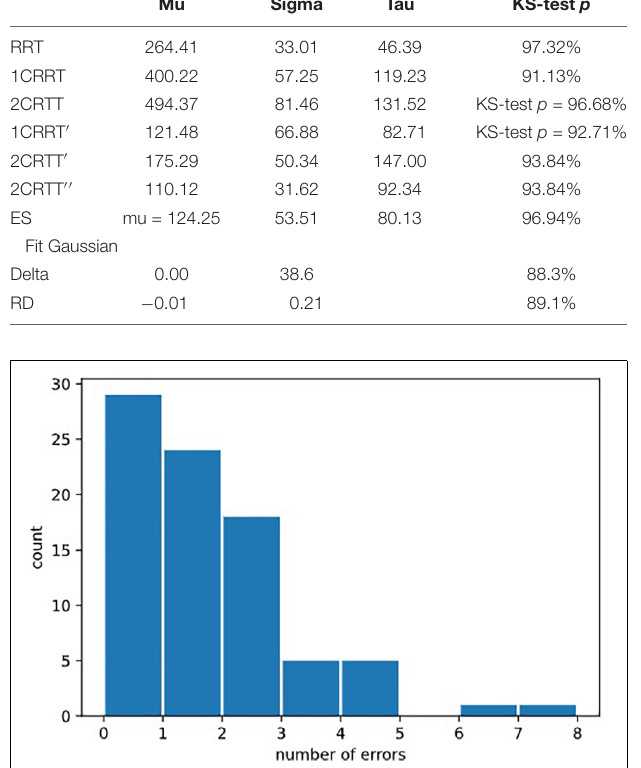
FIGURE 7 | Distribution of erors.Statistical distribution of numbers of errors could not be fitted by a normal law, because it was bounded on the left by the minimal value 0, and by the fact that 0 was the most probable value (in healthy subjects). It would be natural to think that it could be fitted by exponential law (Poisson distribution) but the amount of errors in our data was not sufficient to draw this conclusion.